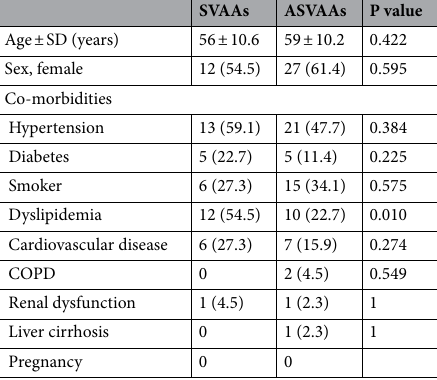
Table 1. Demographic characteristics of symptomatic visceral artery aneurysm (SVAA) and asymptomatic visceral artery aneurysm (ASVAA). COPD chronic obstructive pulmonary disease.